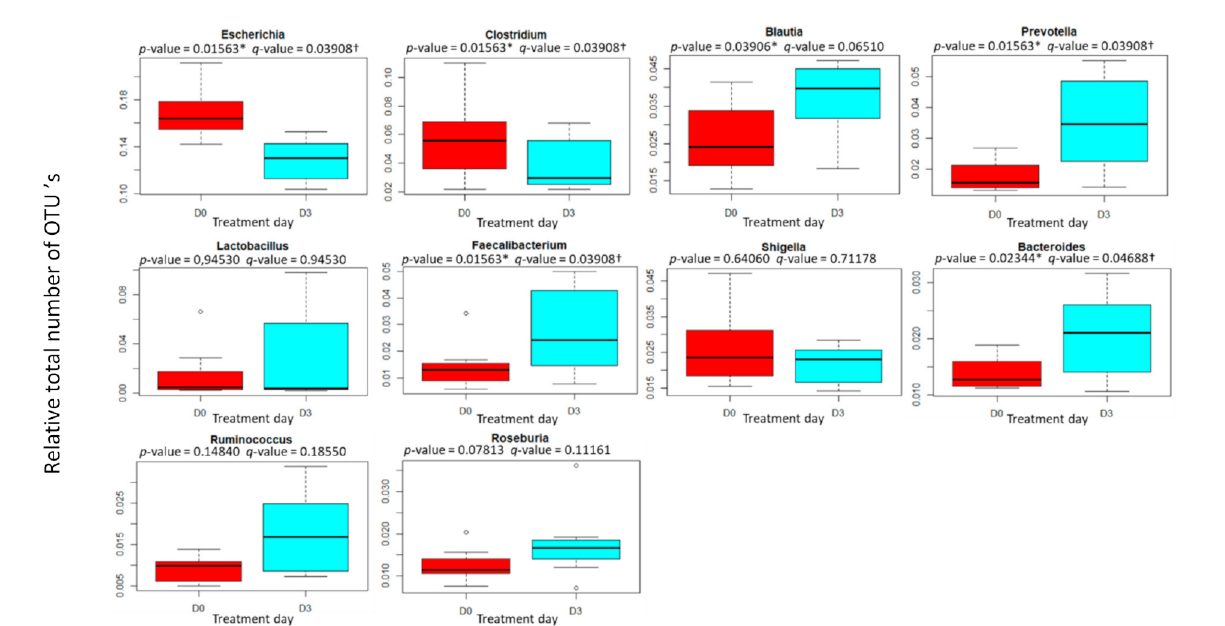
Figure 4. Box-and-whisker plots showing the mean ( n = 8) relative total number of OTUs of the top 10 genera pre-treatment (D0) and post-treatment (D3), i.e., 9 h after the last dose of the daily intramuscular administration of 3 mg · kg − 1 body weight of ceftiofur for 3 consecutive days. Boxes represent the interquartile ranges, the median is depicted by the lines inside the boxes, the whiskers represent the 25% quantile or the 75% quantile plus 1.5 times the interquartile range. Significance codes: ‘*’ p -value < 0.05, ‘†’ q -value < 0.05 (false-discovery-rate-corrected p